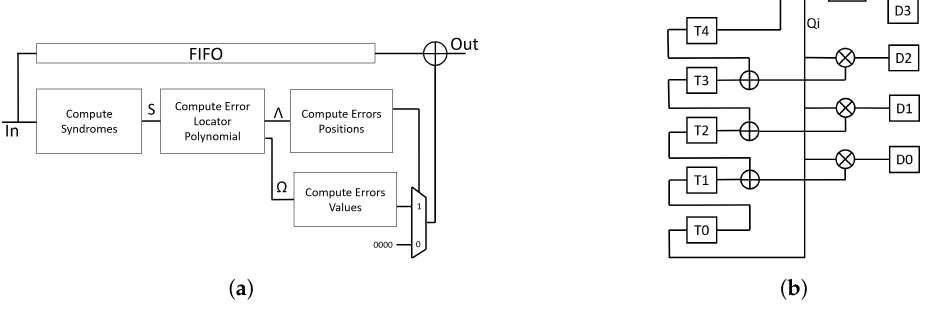
Figure 5. ( a ) Architecture of the FPGA implementation of the RS Decoder and ( b ) architecture of the implemented 4-bits Galois Field (GF) Divider.